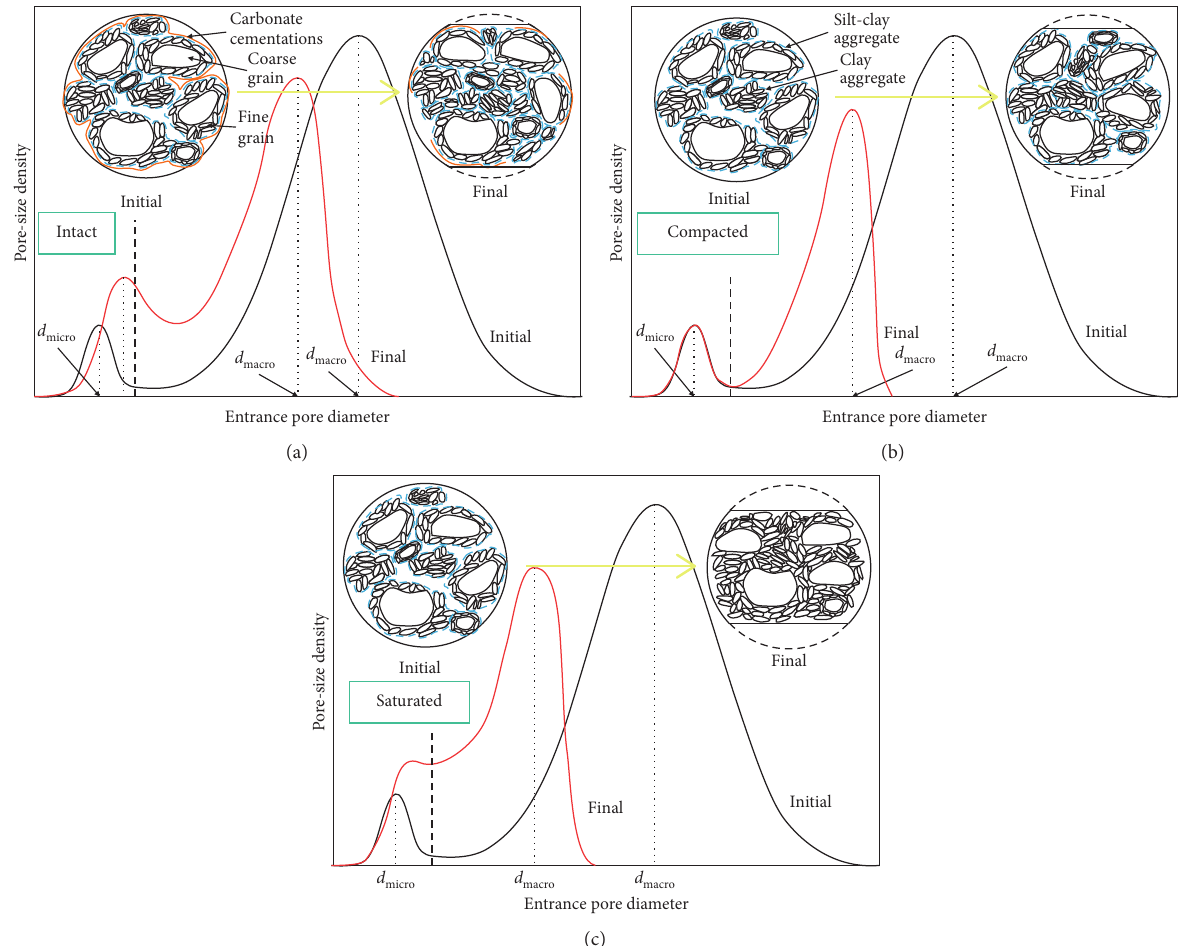
Figure 15: Predicted PSD evolution of (a) compacted loess; (b) intact loess; (c) saturated loess.